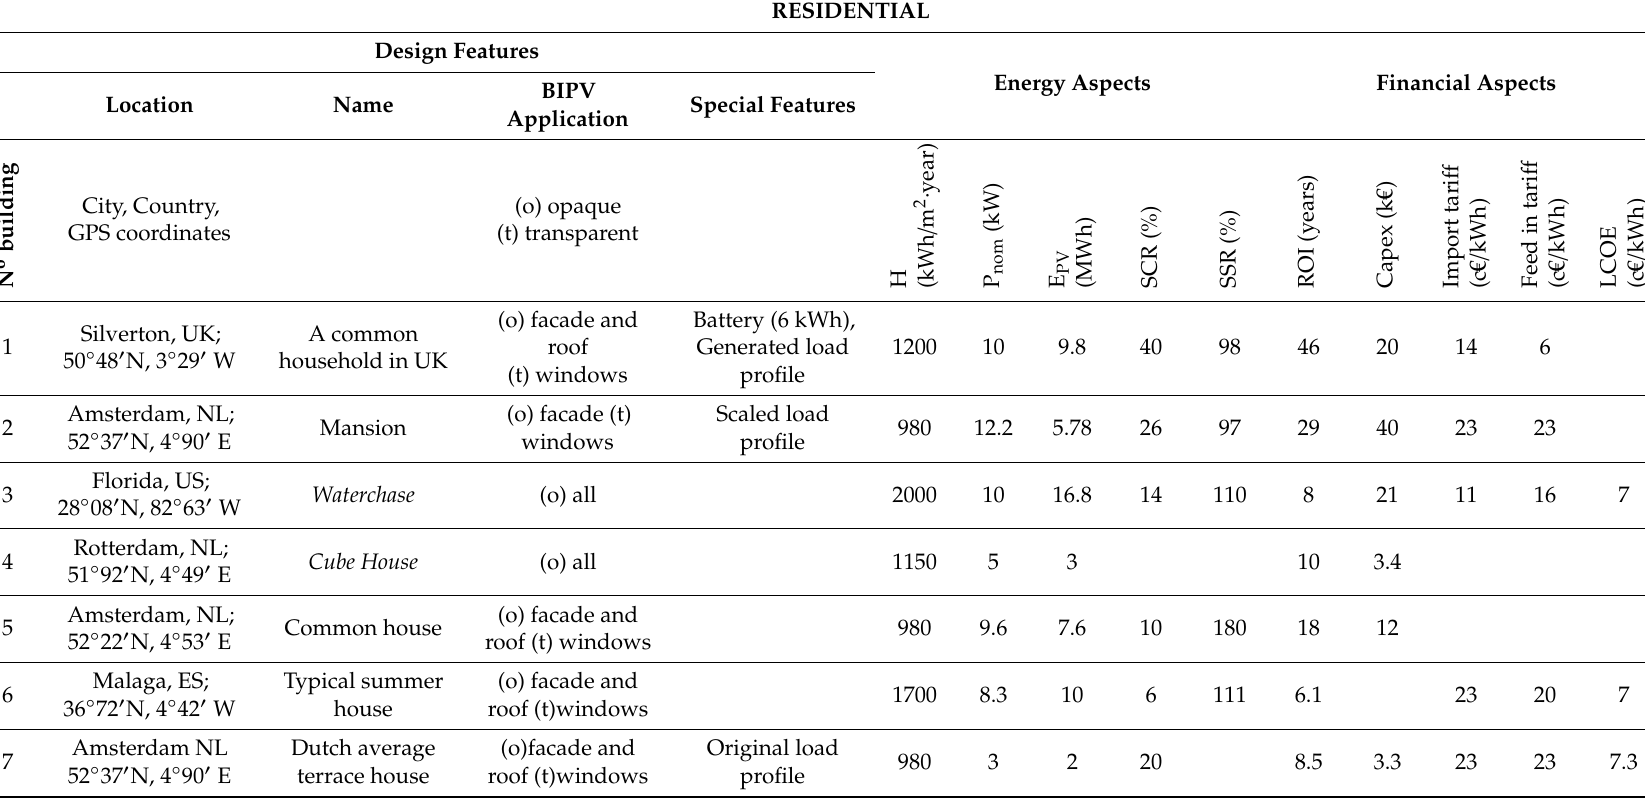
Table 2. Residential projects—design specifications and numerical results in terms of energy and financial